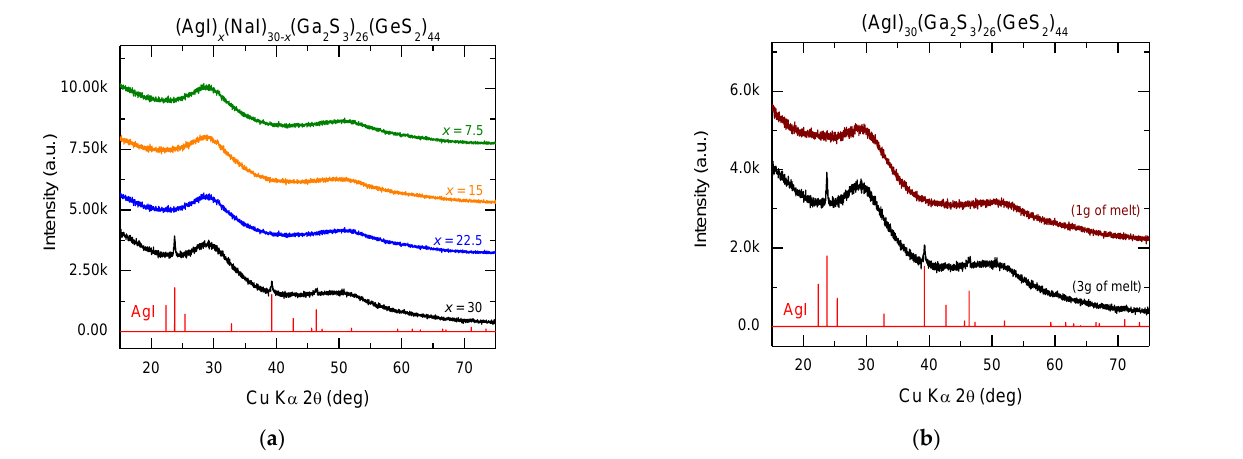
Figure 1. XRD patterns of the (AgI) x (NaI) 30 − x (Ga 2 S 3 ) 26 (GeS 2 ) 44 glasses: ( a ) x = 7.5, 15, 22.5 and 30 mol.% AgI obtained by quenching 3 g of melt and ( b ) x = 30 mol.% AgI obtained by quenching 1 g and 3 g of melt. The diffraction peaks of hexagonal AgI (JCPDS No. 00-009-0374) are included for